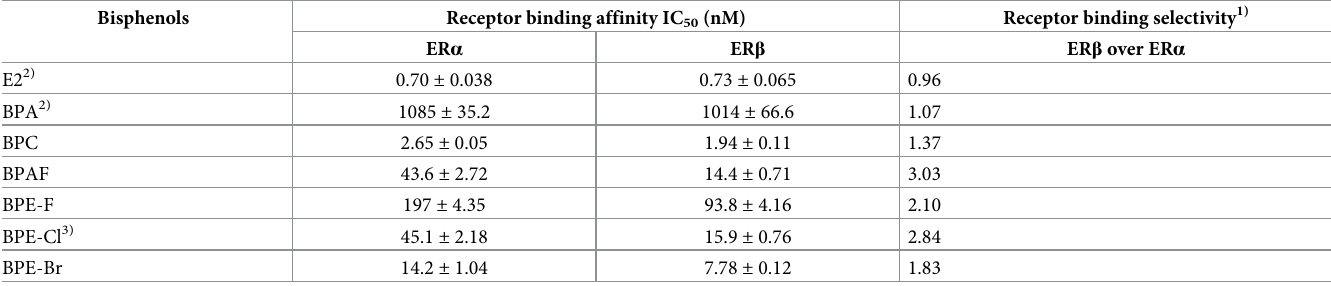
Table 1. Receptor-binding affinities and selectivities of the bisphenol compounds.